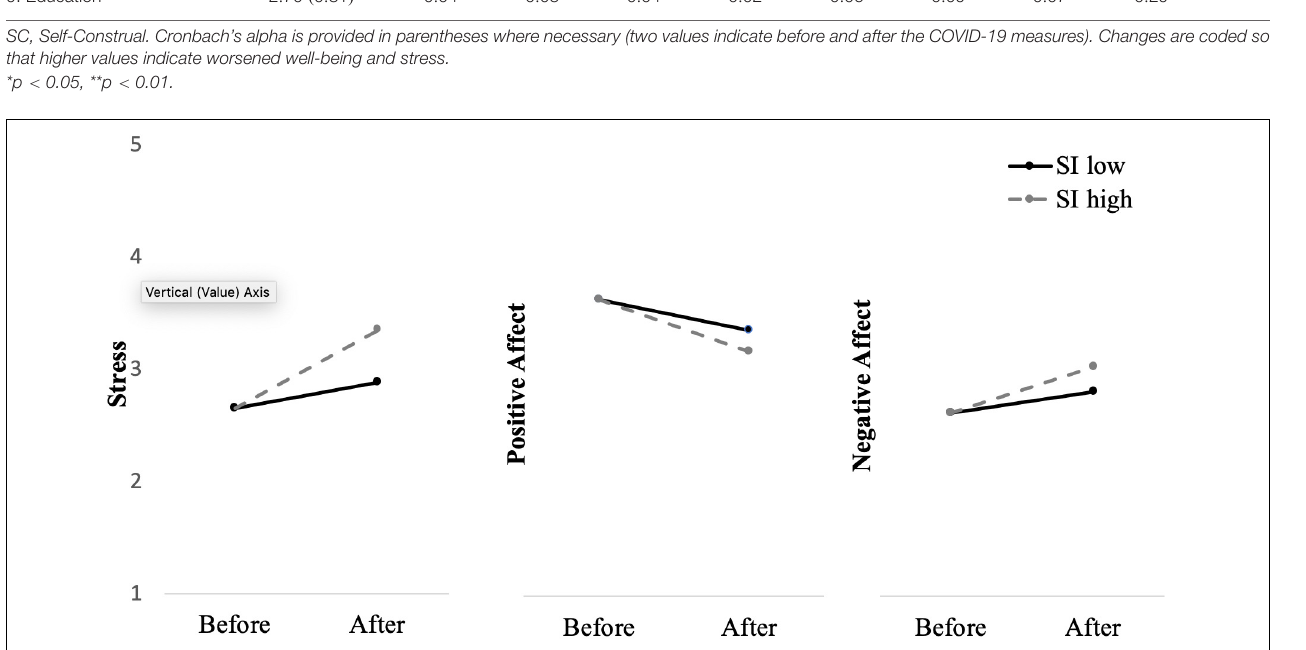
FIGURE 1 | Moderation effects of social interaction on stress and well-being (positive and negative affects) before and after the outbreak in Study 1. SI, Social Interaction; SI low and high indicate mean values − 1 SD and + 1 SD,